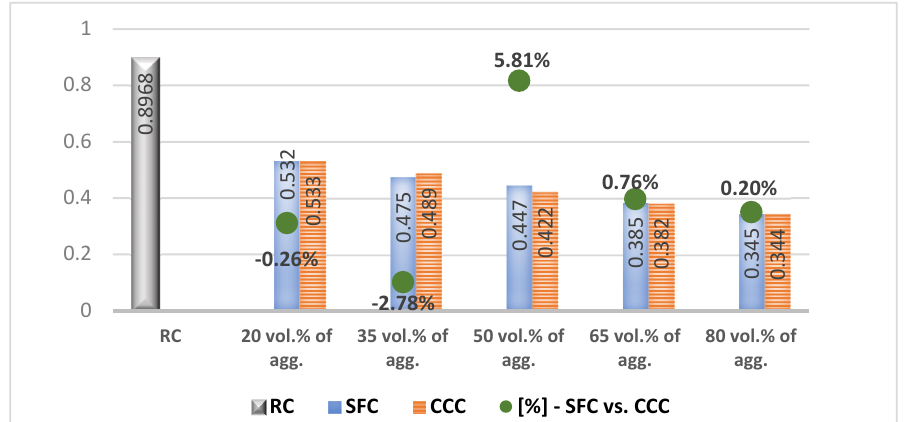
Figure 12. Thermal conductivity of concrete with sunflower aggregates versus that with corn cob aggregates [W/m·K].